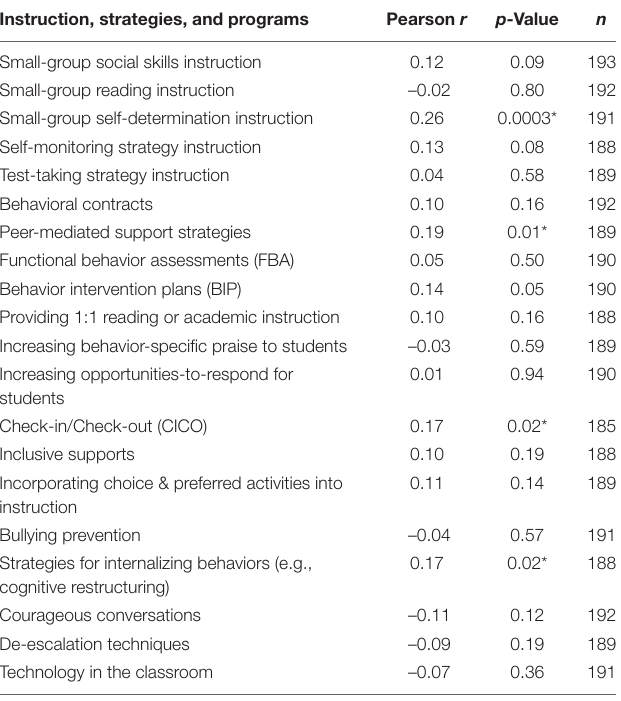
TABLE 5 | Relation between educational practices and supports currently implemented and desire for professional development on how to implement educational